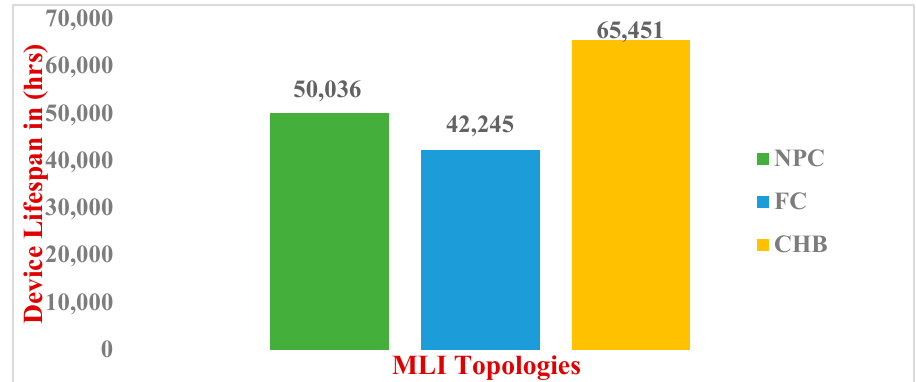
Figure 25. The e ff ect of MLI topologies on device lifespan. Figure 25. The effect of MLI topologies on device